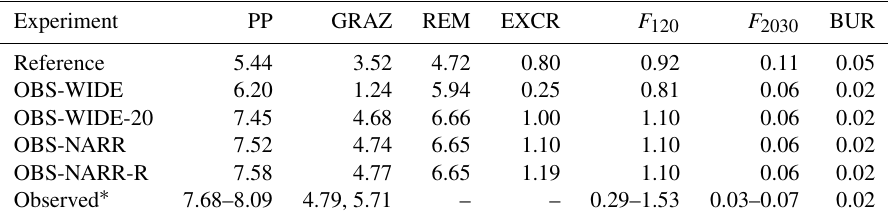
Table 4. Global annual fluxes of primary production (PP), grazing (GRAZ), aerobic and anaerobic remineralization of detritus and DOM to nutrients (REM), excretion by zooplankton (EXCR) export production ( F 120 , flux through 120m), flux through 2030m ( F 2030 ), and benthic burial (BUR), in PgNyear − 1 , for the reference experiment, OBS-WIDE, OBS-WIDE-20, and OBS-NARR (two repeated experiments with different configurations of CMA-ES). We also show some globally derived, observed estimates. Conversion between different elements was carried out via N:P 16 and C:P 122. = =